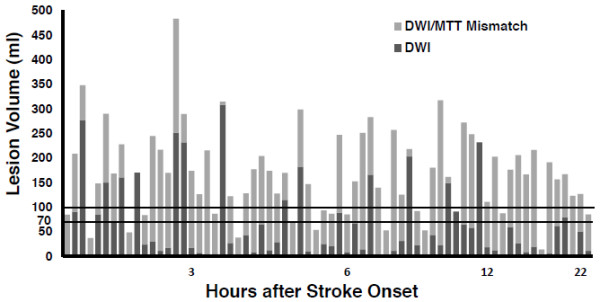
DWI and mismatch volumes of entire retrospective cohort in order of time after stroke onset. Abnormal DWI volume of each patient is depicted as a dark gray bar. Light gray bars represent DWI/MTT mismatch. Horizontal lines demarcate volumes of 70 ml and 100 ml. All patients with DWI lesion volume 70 ml or less had at least a 100% mismatch. There was no significant correlation between time from stroke onset and DWI lesion volume or between time and mismatch volume. DWI: Diffusion weighted imaging; MTT: Mean transit time.